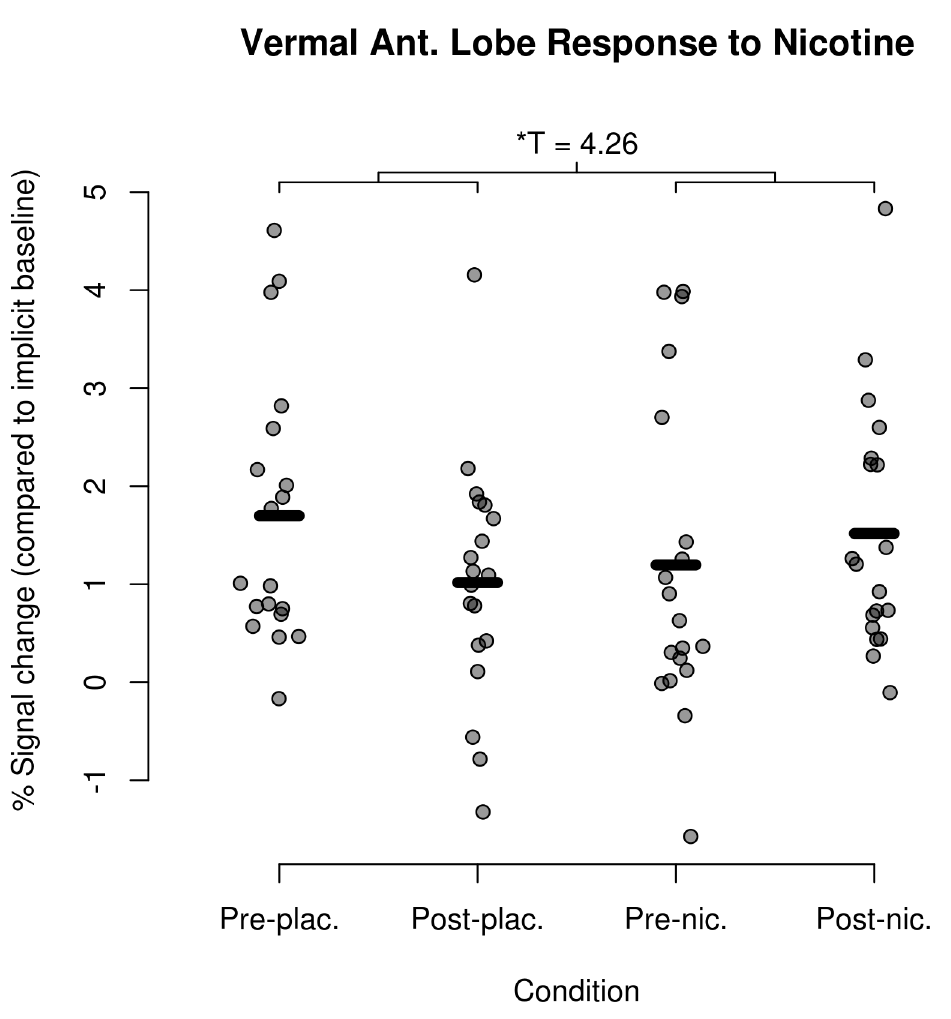
Figure 2. Vermal anterior lobe response to nicotine. Mean hemodynamic response by subject & condition from the peak activation within the vermal anterior lobe, with bars indicating the sample mean for each